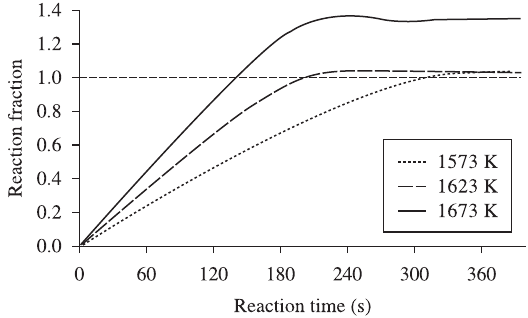
Figure 2. Reaction fraction as a function of time for iron ore-graphite composite pellets heated at different temperatures. the carbon content of the iron was not enough to attain the liquidus temperature of the iron-carbon alloy due to a low carburizing rate, whereas at 1673 K the same occurred due to loss of carbon caused by the violent flow of product gases. At the intermediate temperature of 1623 K, both the carburizing rate and the carbon loss could have prevented the nugget